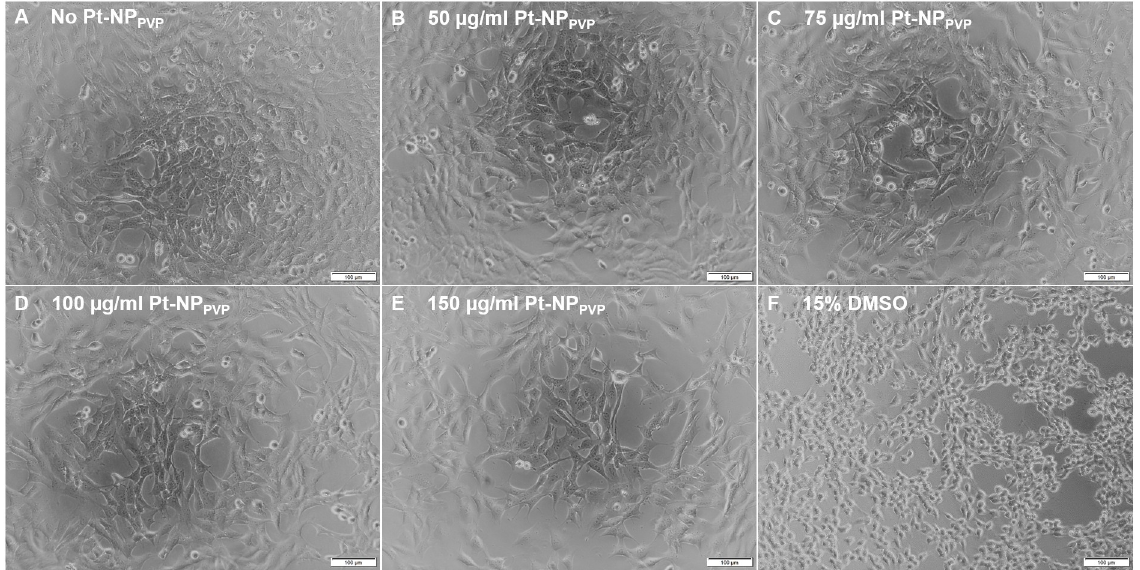
Fig 1. Microscopic view of the morphology of the HEI-OC1 cells following exposure to Pt-NP PVP . HEI-OC1 cells were cultivated either without Pt-NP PVP administration as reference (A) or in culture medium containing 50 μ g/ml (B), 75 μ g/ml (C), 100 μ g/ml (D) and 150 μ g/ml (E) of the Pt-NP PVP . The cell culture assay exposed to 15% DMSO for 1.5 h was used as negative control (F). The transmission light images demonstrated highly uniform cell adhesion without any morphological damage throughout the cell cultures assays with and without varying Pt-NP PVP concentrations. Size of the bars: 100 μ